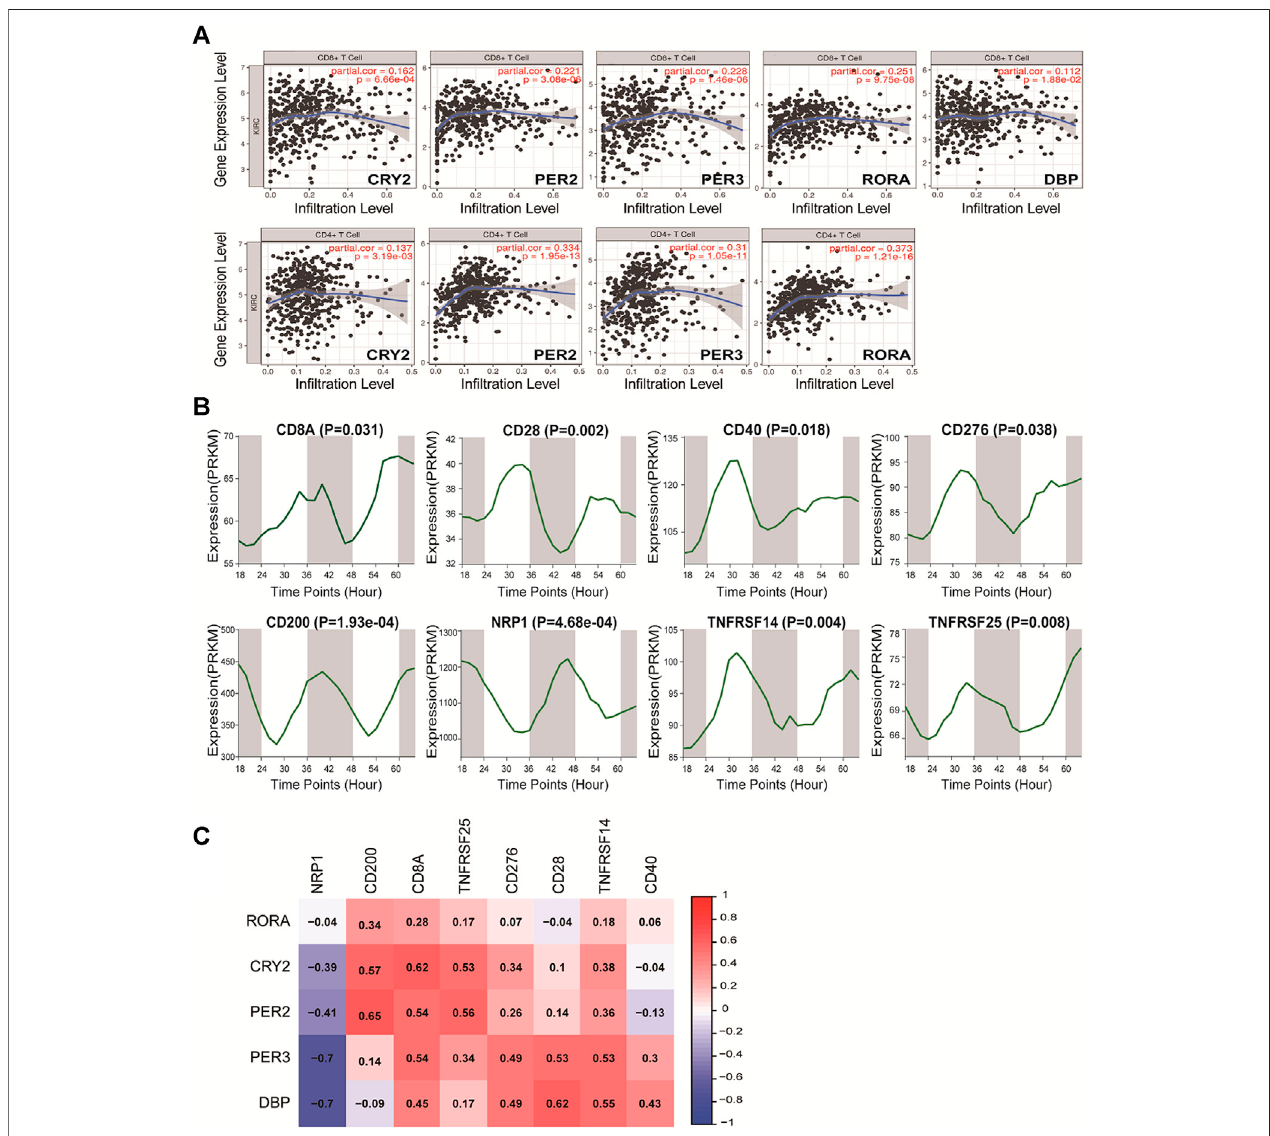
FIGURE 7 | Correlation of fi ve prognostic core clock genes with immune in fi ltration. (A) The fi ve prognostic core clock genes were correlated with CD8 T cells and CD4 T cells. The abscissa represent the in fi ltration level and the ordinate represent the gene expression level. (B) The rhythmic expression patterns of eight immune cell markers at different time intervals in mice renal tissue ( Mus GSE54652). (C) The expression of fi ve prognosis clock control genes was associated with the expression of thesekeyimmune genes.Here,columnsrepresent keyimmune genesandrows represent clockgenes,red represents positivecorrelationbetweenrhythmgenes and immune genes, and blue represents negative correlation between rhythm genes and immune